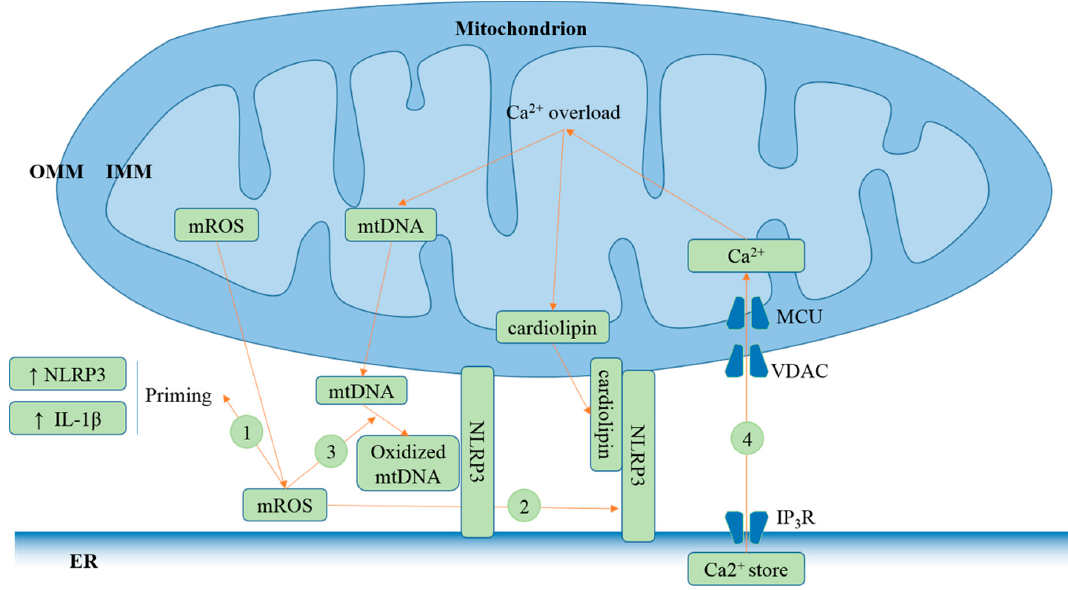
Figure 3. MAMs contribute to NLRP3 inflammasome activation. (1) ER–mitochondria proximity